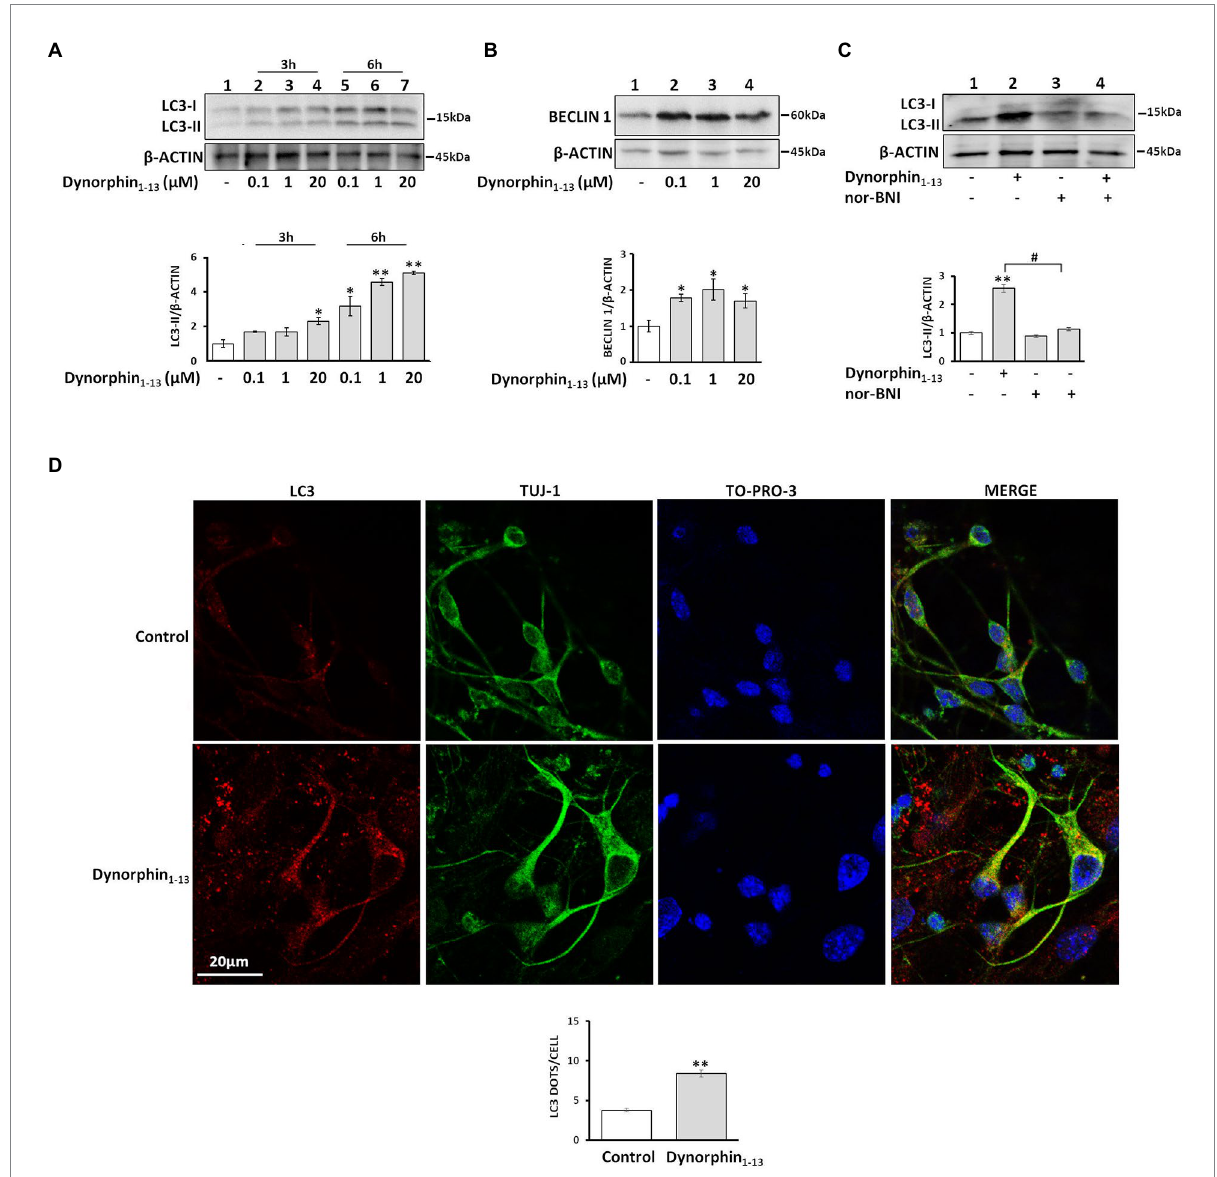
FIGURE 2 Dynorphin induces κ - Ο R-mediated autophagy in neuronal cells. Treatment of κ -Neuro-2A cells with dynorphin results in upregulation of LC3-II in a dose-and time-dependent manner. (A,B) . The levels of LC3-II (A) and Beclin1 (B) after dynorphin 1-13 treatment for 6 h were detected by Western blotting and normalized to β -actin levels. Data represent mean SEM ± of three independent experiments; Statistical analysis was performed using one-way ANOVA. * p < 0.05 and ** p < 0.01 as compared to untreated samples. (C) κ -Neuro-2A cells were pre-treated for 1 h, with or without the κ - Ο R antagonist nor-BNI (5 μ M) following administration with 1 μΜ dynorphin for 6 h. The LC3-II levels were detected by Western blotting. β -actin served as loading control. Error bars represent mean ± SEM of three independent experiments. Statistical analysis was performed using two-way ANOVA, ** p < 0.01 as compared with untreated samples, # p < 0.05 as compared with samples in the presence of nor-BNI. (D) Representative confocal images of hippocampal embryonic DIV 10 neurons were treated or not with 1 μΜ dynorphin for 6 h and immunostained with antibodies against LC3B (1:200) and Tuj1 (1:1000) to label autophagosomes and mature dendrites, respectively, and the nuclear dye TO-PRO3 (1:500). Statistical analysis was performed using one-way ANOVA. ** p < 0.01 as compared with untreated